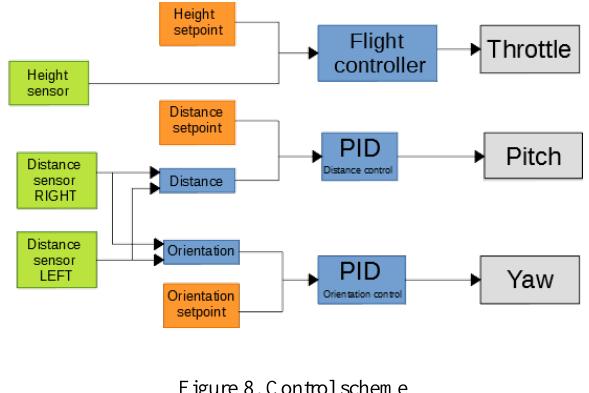
Figure 8. Control scheme